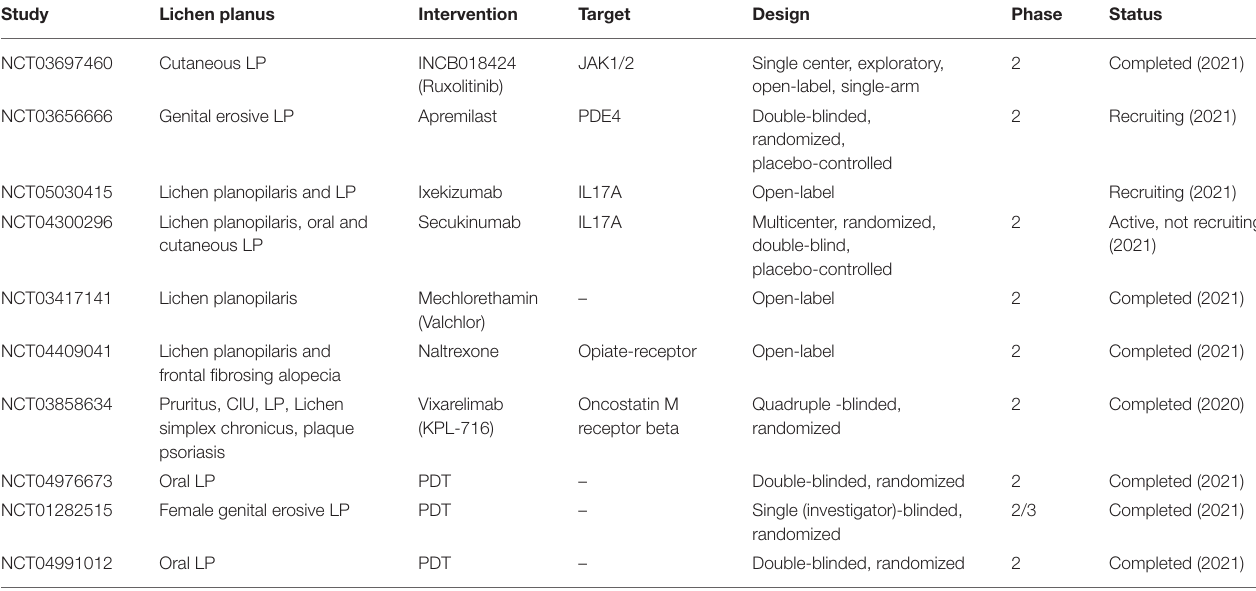
TABLE 4 | Selected clinical studies in lichen